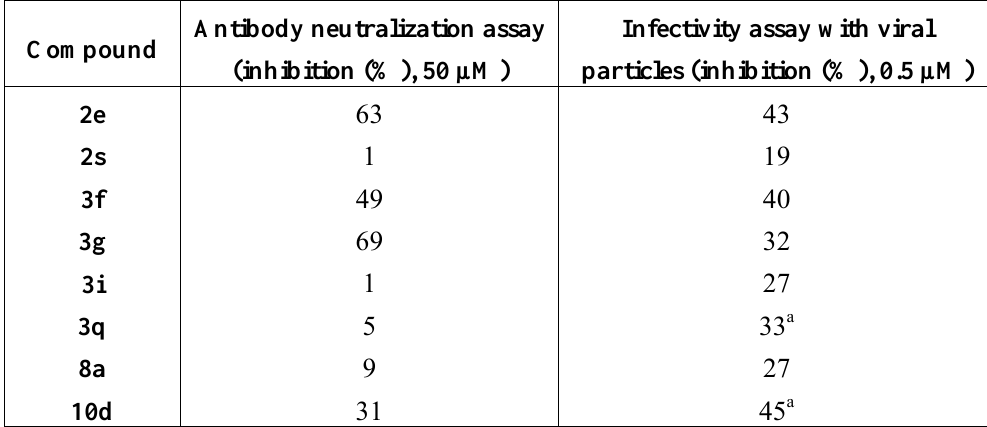
Table 9. Inhibition of infectivity of viral particles by selected compounds. Antibody neutralization assay Infectivity assay with viral Compound (inhibition (%), 50 µM) particles (inhibition (%), 0.5